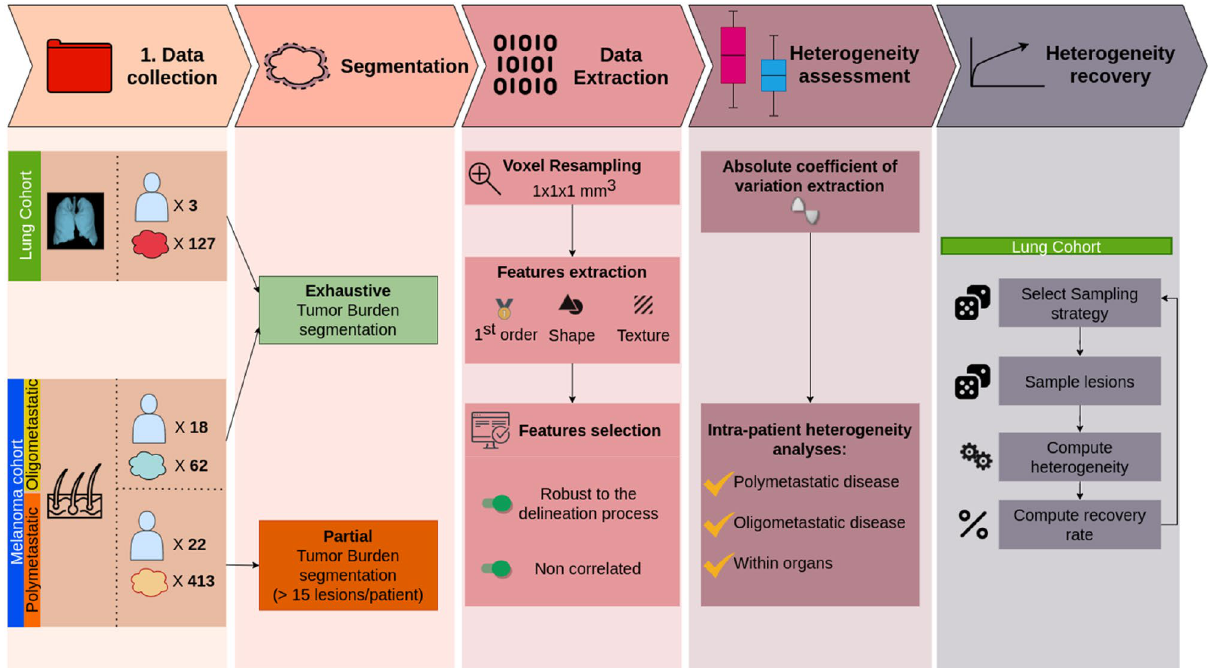
Figure 2. General view of the data pipeline and the analysis process.